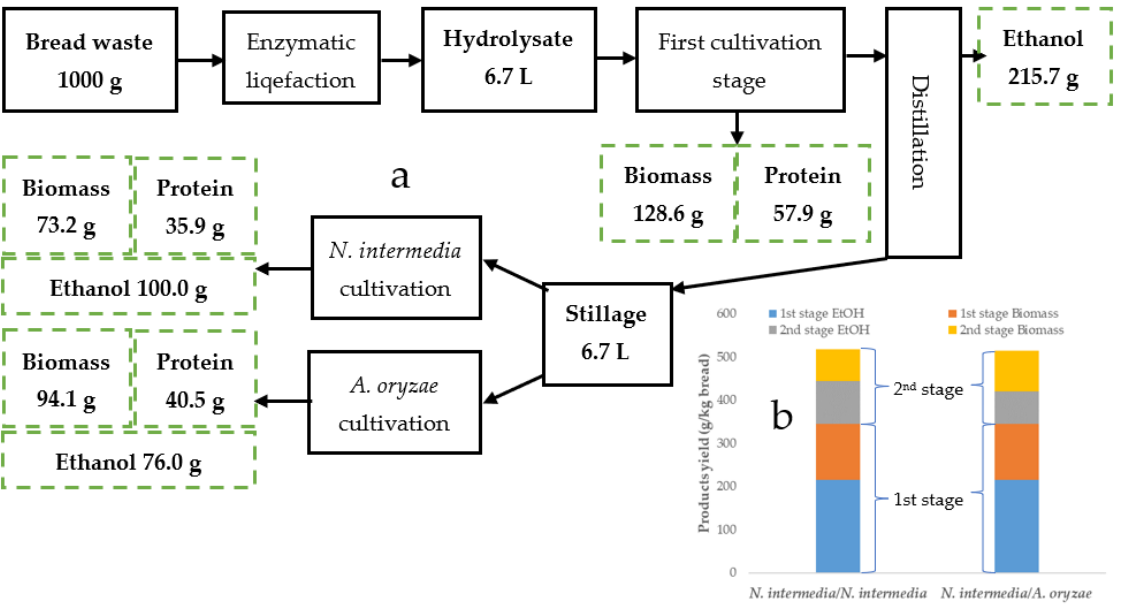
Figure 3. Mass balance for the process of bread waste valorization using edible filamentous fungi ( a ). The streams of the products obtained are contained in the dashed green line blocks. The bar graph ( b ) shows the comparison of fungal biomass and ethanol production in both fermentation stages depending on the fungal strain used.